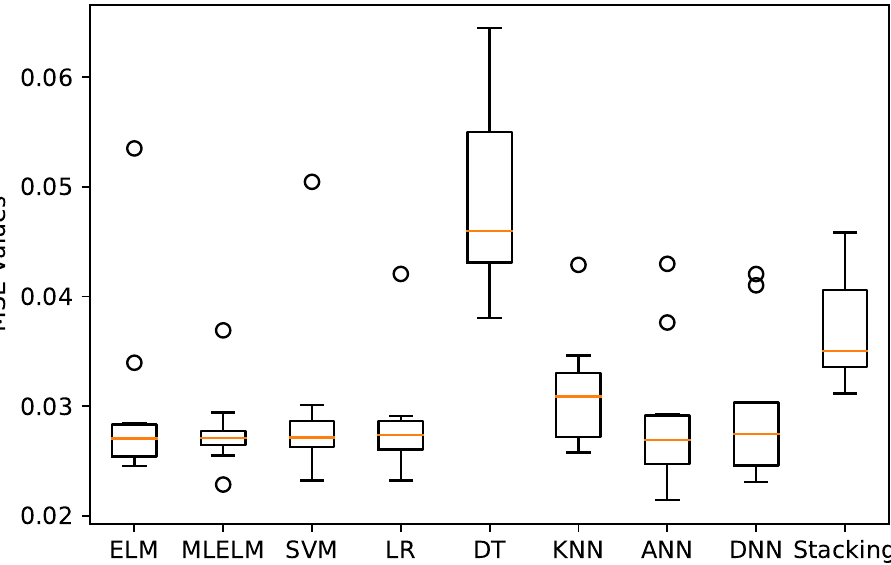
Figure 9. The performance of various models for annual building energy consumption: MSE